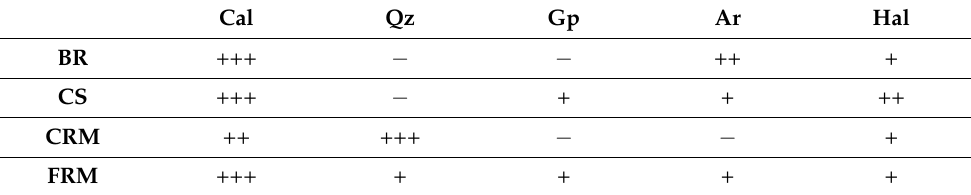
Table 3. Mineralogical analysis of Anfushi’s Necropolis samples. BR: bedrock; CS casting stone; CRM: coarse-grained rendering mortar; FRM: fine-grained rendering mortar; Cal: calcite; Qz: quartz; Gp: gypsum; Ar: aragonite and Hal: halite (+++ very abundant; ++ abundant; + rare, − not detected). Cal